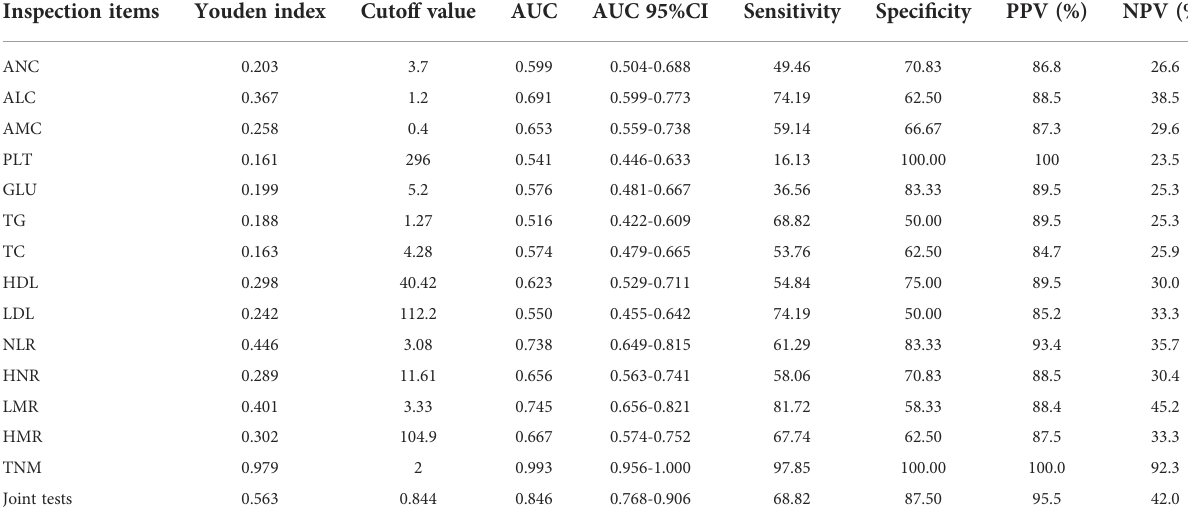
TABLE 3 The analysis of the expression levels of each test items in NSCLC metastasis. Inspection